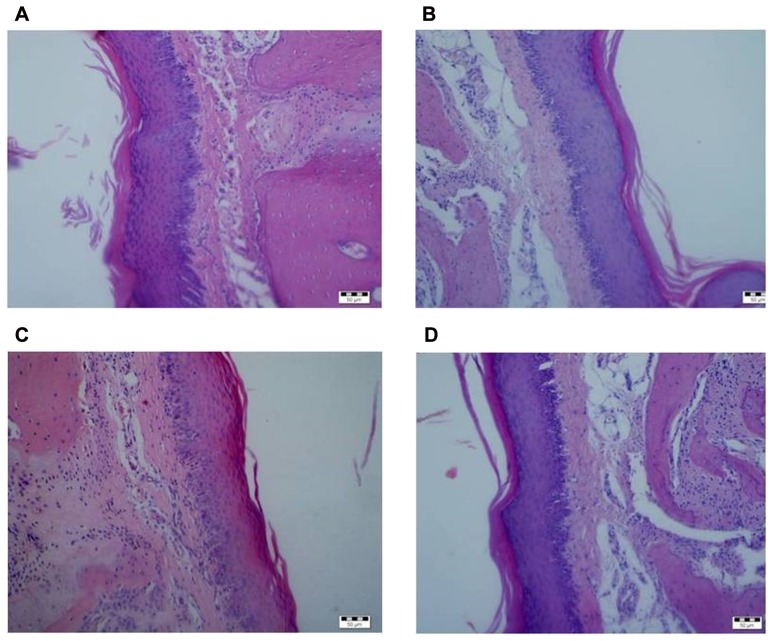
Photomicrograph of paraffin sections of Wistar rat keratinized palatal oral mucosa after hematoxylin eosin staining (200X) (A = group G2, B =  group G3, C =  group G4, D =  group G5).